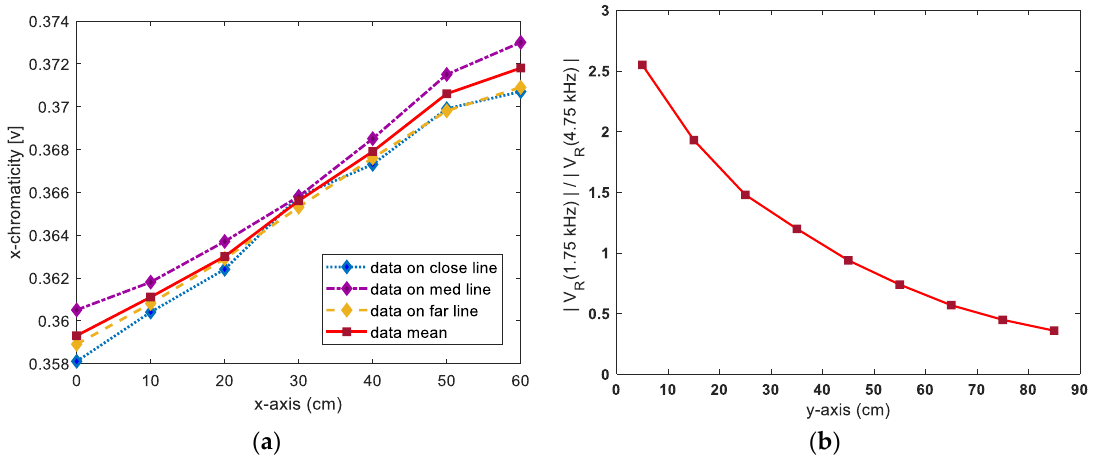
Figure 3. Reference-data variations along x- and y- axes: ( a ) Chromaticity variation along x-axis; ( b ) frequency-component- ratio variation along y-axis.